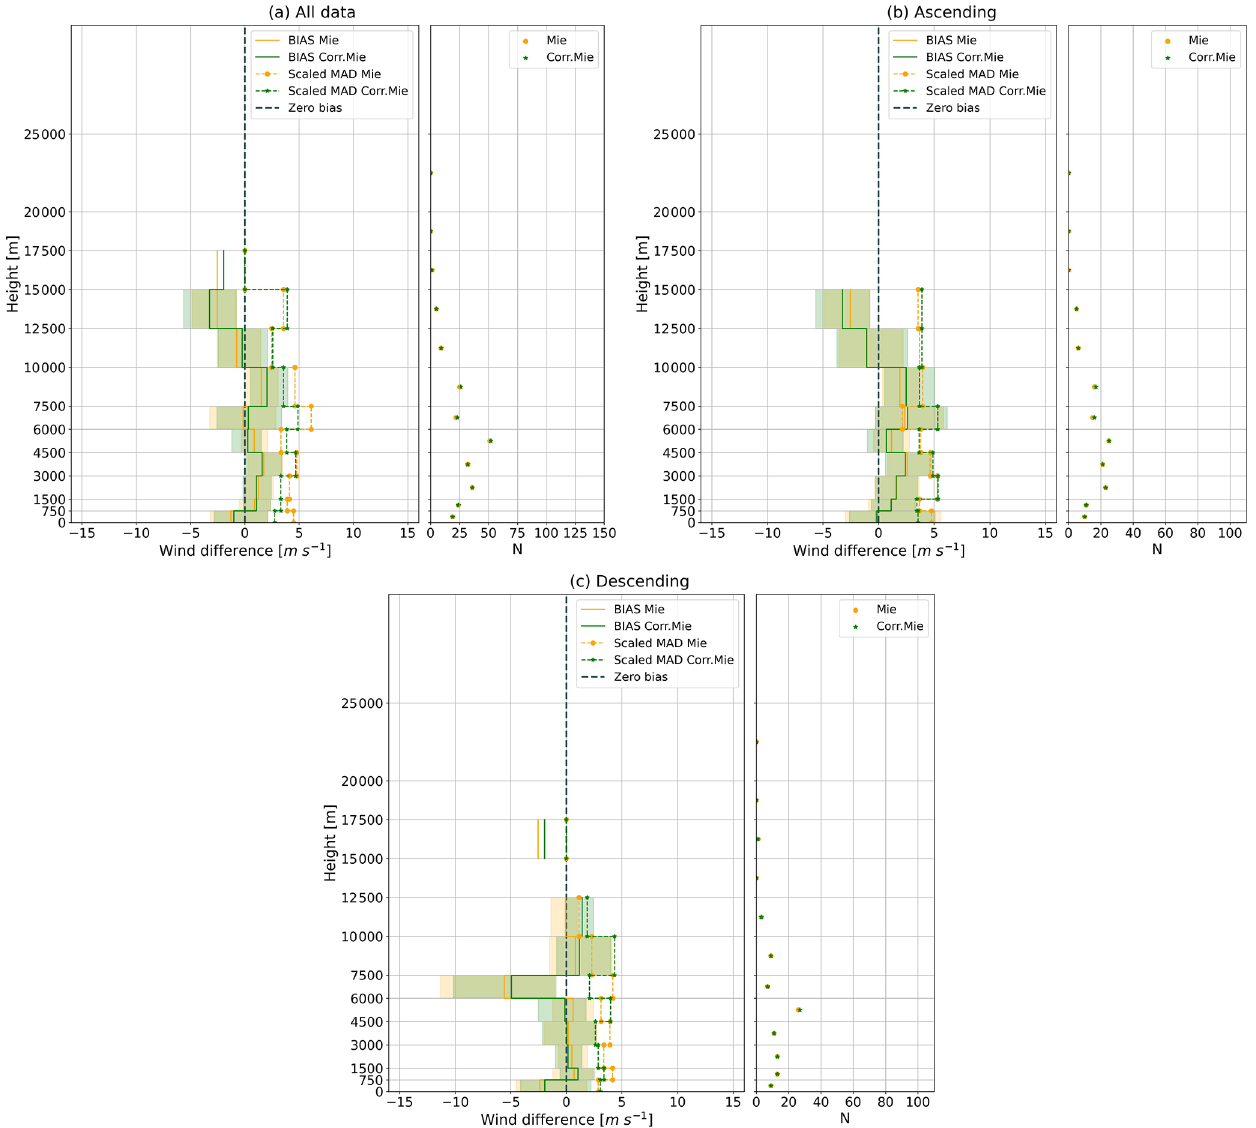
Figure A2. Wind differences (Aeolus-WPR) with height for (a) all data, (b) ascending orbits, and (c) descending orbits. Left: bias and scaled MAD of wind differences as a function of height, with shaded areas representing the uncertainty. Right: the number of available match-ups at each height. Orange and green colours indicate the results for Mie-cloudy and corrected Mie-cloudy winds, respectively.